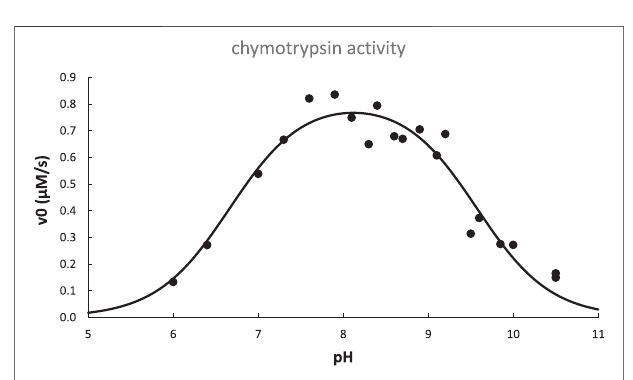
FIGURE 6 | pH dependence of chymotrypsin-catalyzed hydrolysis of N-acetyl-L-tryptophanamide at 25 ° C. Data adapted from (Himoe et al., 1967) are fi t to Eq. 13 with best- fi t parameters: pK a,lo (cid:2) 6.67 ± 0.11, pK a,hi (cid:2) 9.57 ± 0.08,